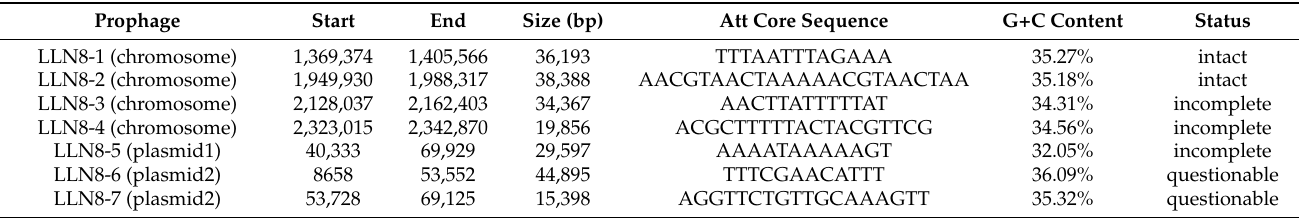
Figure 5. Prediction of the functional protein of each prophage. Table 4. Information of prophage-related